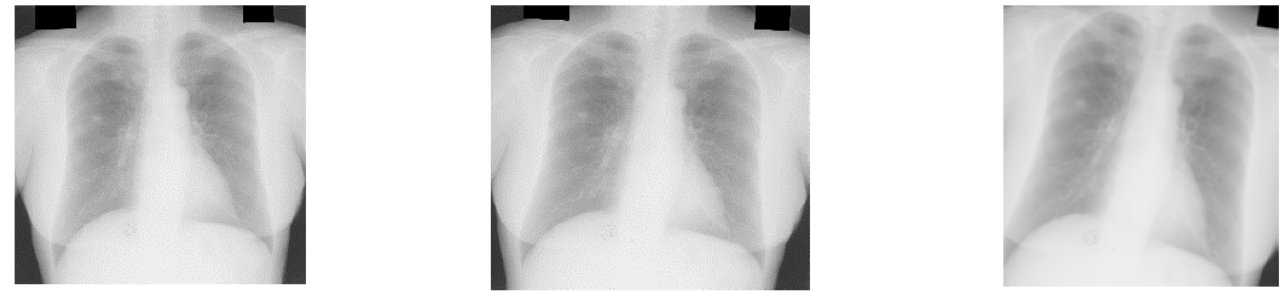
Figure 2. Augmented images from the JSRT dataset with different rotation degrees.